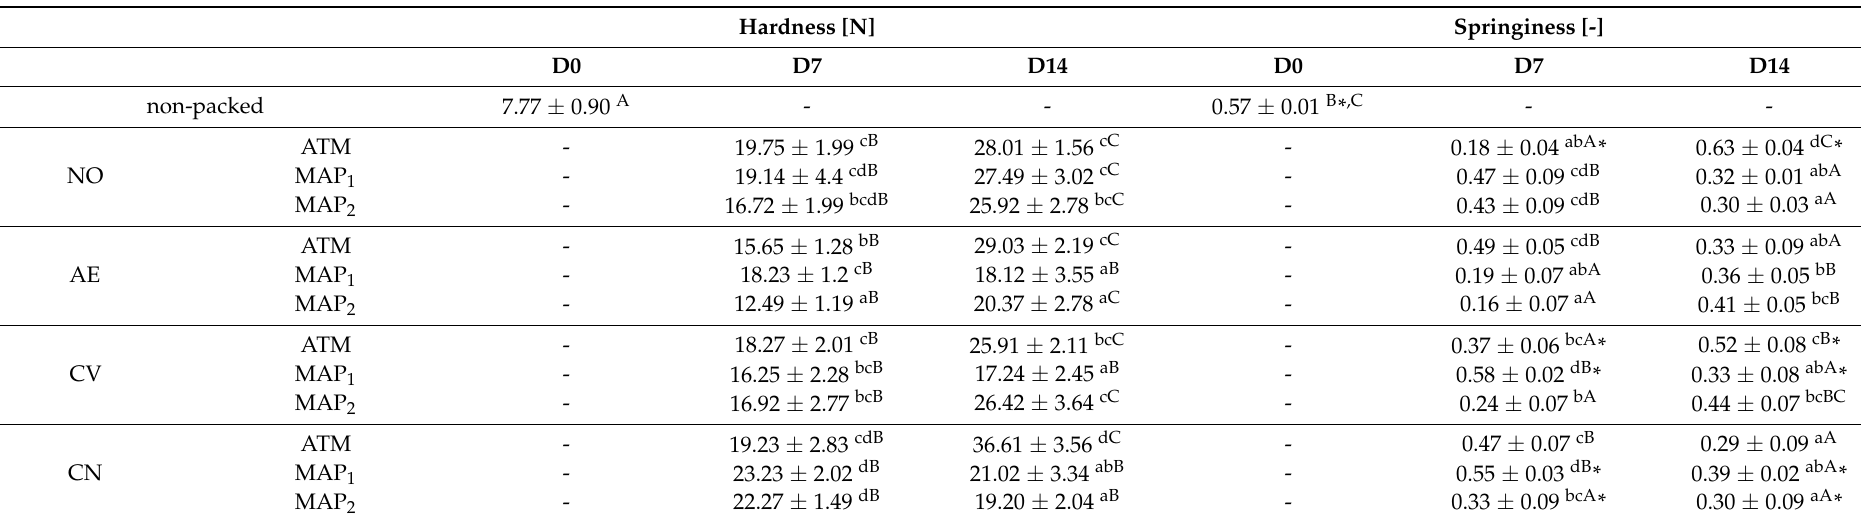
Table 4. Changes in hardness and springiness during 14-days storage of GF cake (mean ± SD; n =